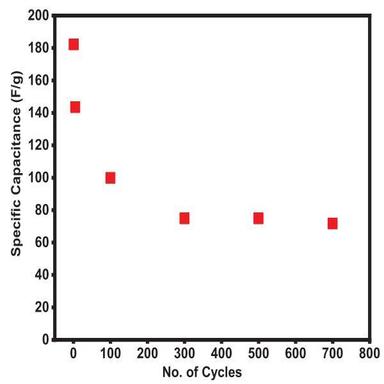
Cyclic stability of Pr6O11/Mn3O4-2 at a current density of 5 A/g.